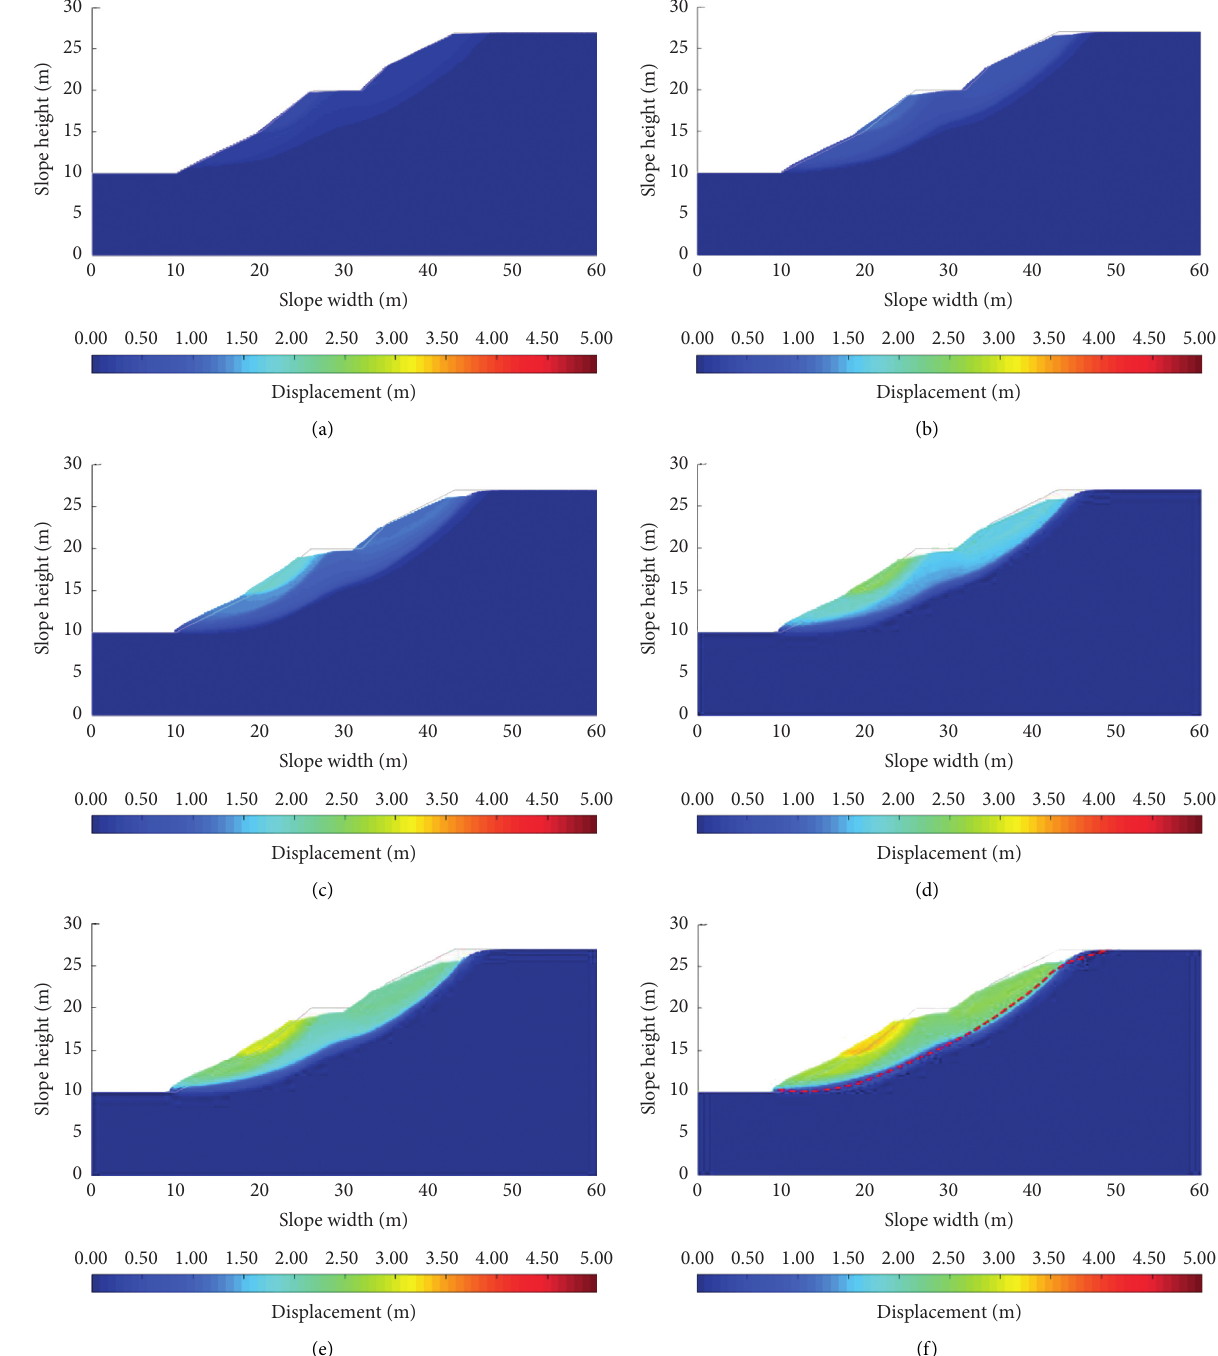
Figure 7: Contour plot of deformation for slope particles at different times: (a) t � 1s; (b) t � 2s; (c) t � 3 s; (d) t � 4s; (e) t � 5s; (f) t � 6s (the dotted line in (f) represents the result from MPM